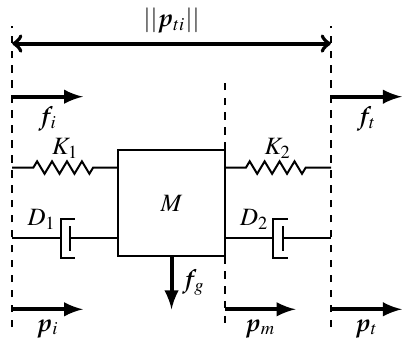
) and damper ( D ) pairs. The index finger and thumb apply forces 1,2 1,2 { } { }